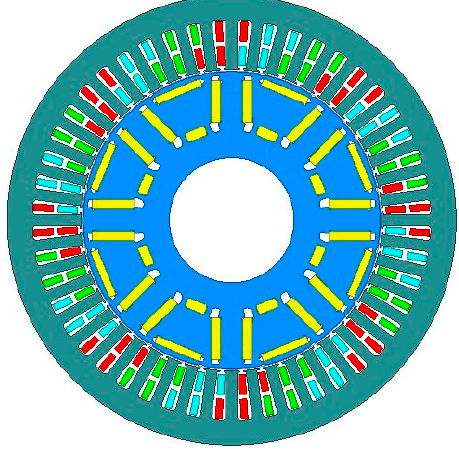
Figure 7. Effect of multi-physical field coupling on the magnetic properties of 10JNEX900. ( a ) Trend of B. ( b ) Trend of P.